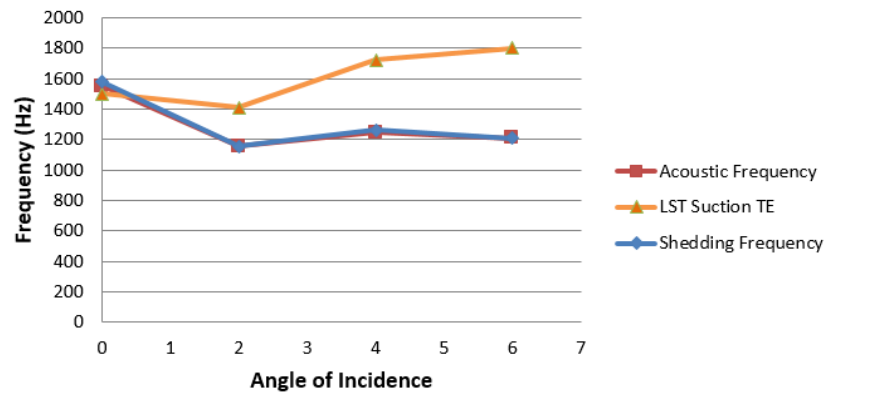
Figure 21. LSA-predicted (triangles), shedding (diamonds), and acoustic (squares) peak frequen- cies [18].